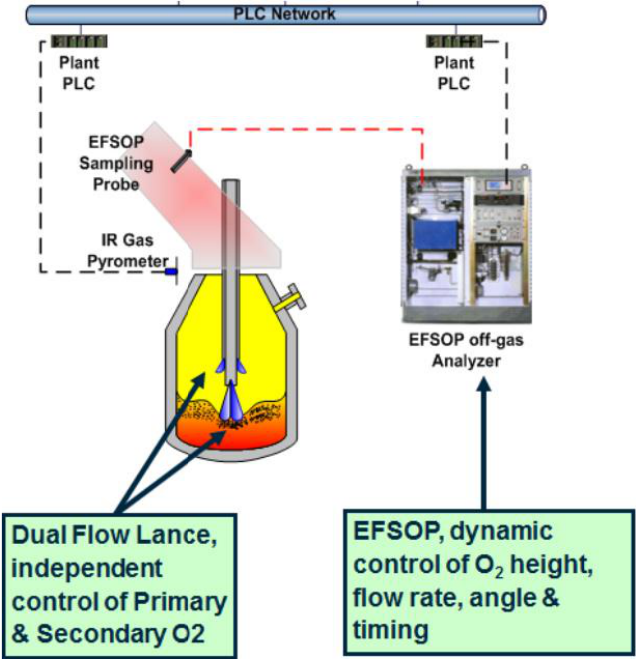
Figure 9. iBOF optimized post-combustion module, adapted from [48].